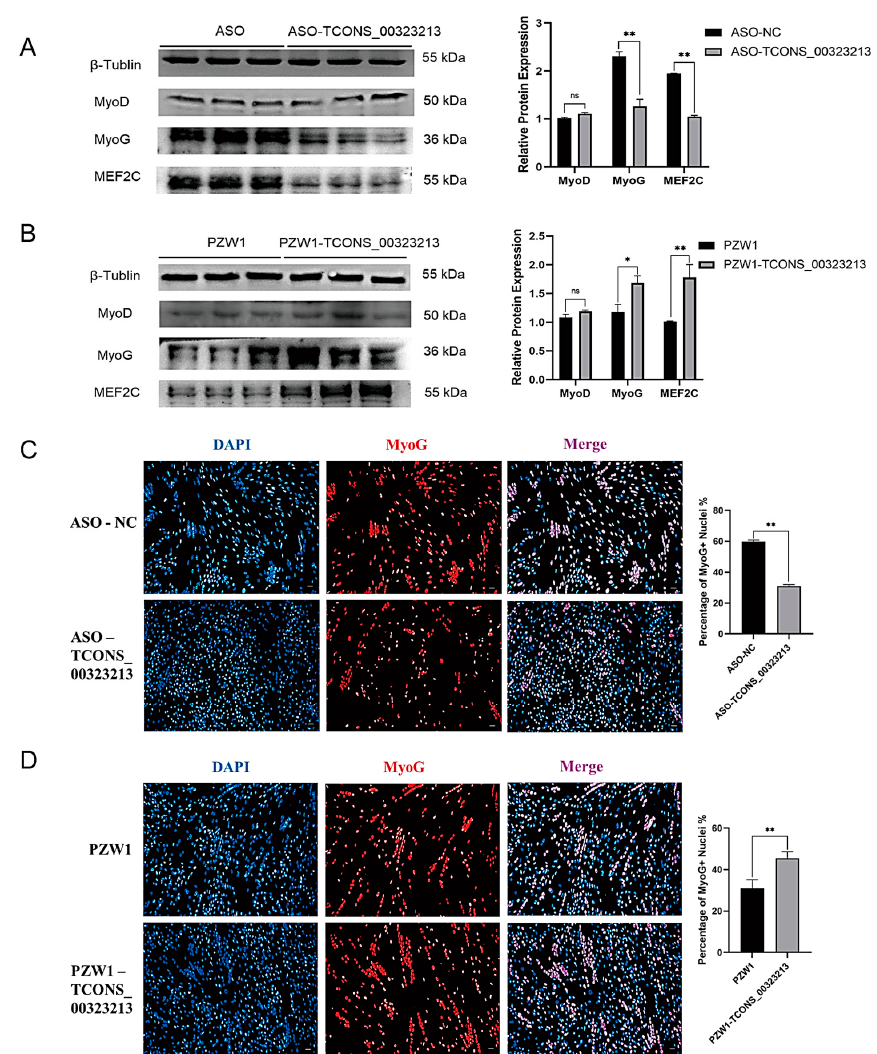
Figure 2. TCONS_00323213 promotes myoblast di ff erentiation. ( A ) Western blot analysis of MyoD, MyoG, and MEF2C expression levels after TCONS_00323213 knockdown. ( B ) Western blot analysis of MyoD, MyoG, and MEF2C expression levels after TCONS_00323213 overexpression. The western blot results contained three biological replicates in each group. ( C ) In PSCs di ff erentiated for 36 h, a knowckdown of TCONS_00323213 signi fi cantly decreased MyoG expression. ( D ) Immuno fl uores- cence staining in PSCs di ff erentiated for 36 h showed that TCONS_00323213 overexpression signif- icantly increased the MyoG expression level. Mean values ± SD, n = 3. * p < 0.05, ** p < 0.01. ns indicates no signi fi cant di ff erence. 2.3. TCONS_00323213 Interacts Directly with PBX/Kno tt ed Homeobox 2 To explore the function of TCONS_00323213 , an RNA pull-down assay was per- formed to identify the interacting proteins of TCONS_00323213 (Figure 3A). Given that the TCONS_00323213 full-length sequence is excessively long, we truncated TCONS_00323213 into 5 biotinylated fragments (Figure 3B) and incubated these frag- ments with cell lysates from di ff erentiated PSCs for 36 h. RNA-binding proteins were cap- tured with streptavidin magnetic beads. Among the di ff erentially expressed proteins de- tected by MS, the transcription factor PBX/Kno tt ed Homeobox 2 ( PKNOX2 ) was of par- ticular interest. PKNOX2, a member of the PREP family, is highly expressed in skeletal muscle tissue [23]. The western blot showed that PKNOX2 was captured by biotinylated